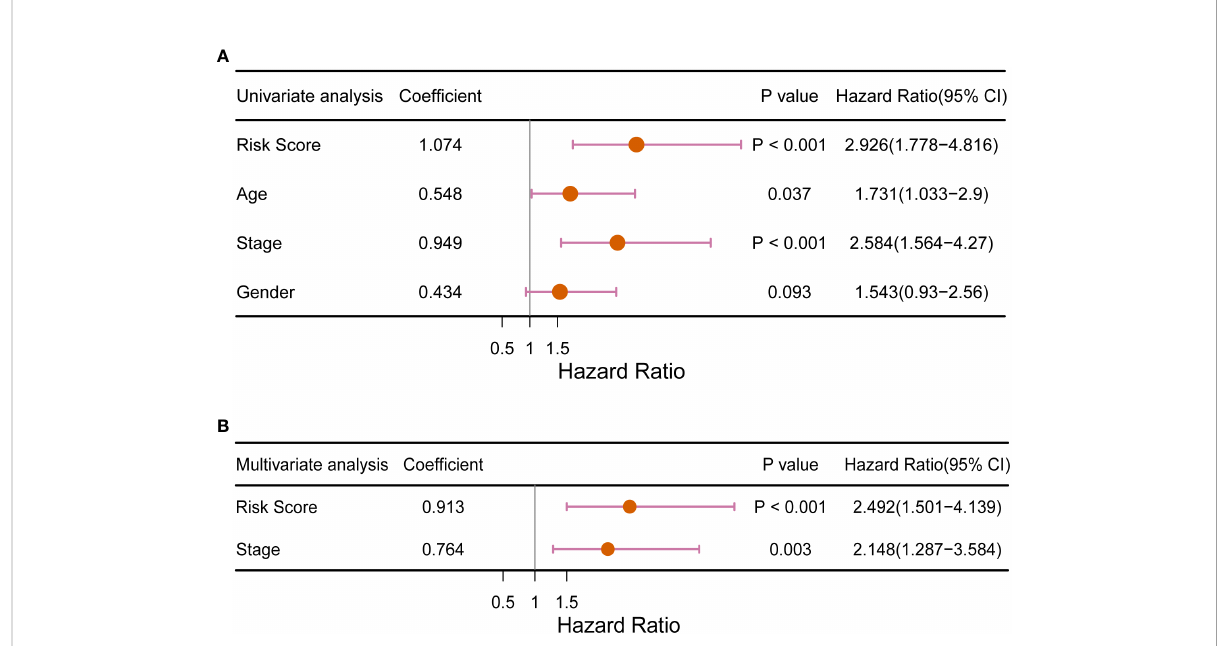
FIGURE 6 Forest plot of (A) univariate and (B) multivariate Cox regression analysis of the RS signature compared with traditional clinical factors for its ability to predict the prognosis of CRC